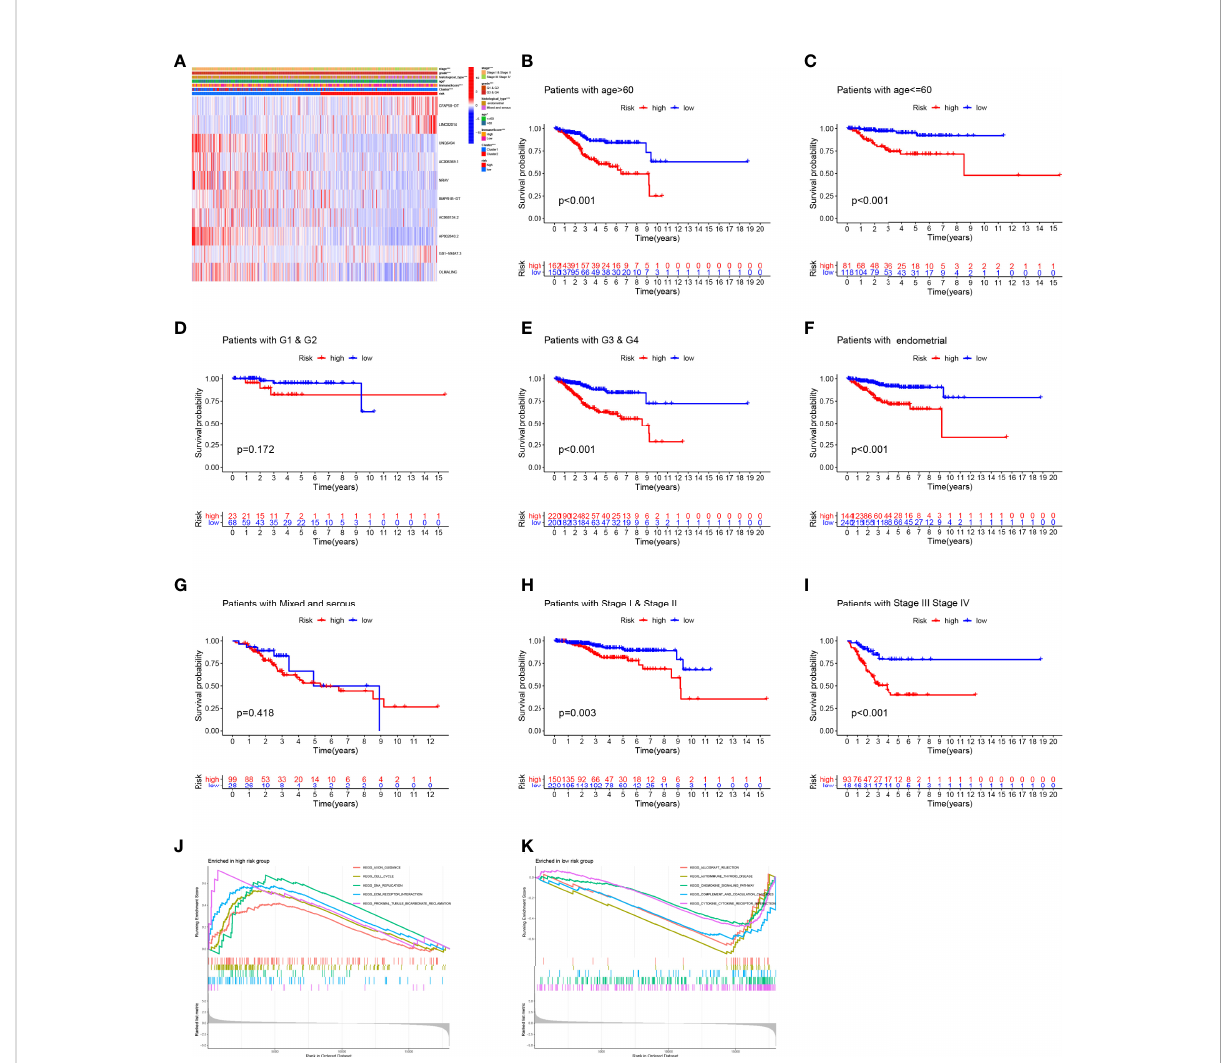
FIGURE 7 Correlation between clinical parameters and prediction signature. (A) The detailed characteristic distribution of two groups. (B – I) The prognostic model could effectively discriminate the prognosis of the patients strati fi ed by different clinical factors (age, grade, histological type, and stage). (J, K) GSEA